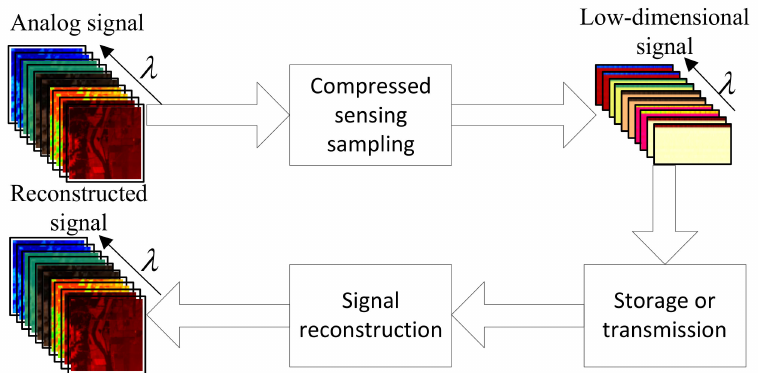
Figure 1. Block diagram of compressed